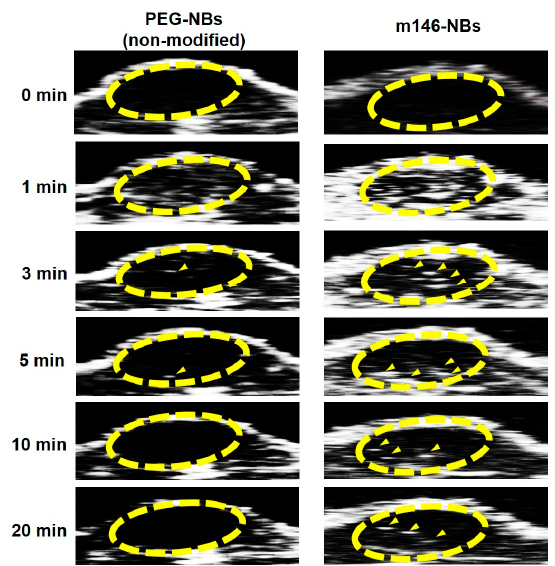
Figure 4 . US imaging of tumor-bearing mice injected with NBs. Tumor-bearing mice (tumor size: approximately 100 mm 3 ) were intravenously injected with NBs as lipids at a dose of 200 µ g / 200 µ L. The circles show the area of the tumor, and the arrowheads indicate enhanced contrast images.